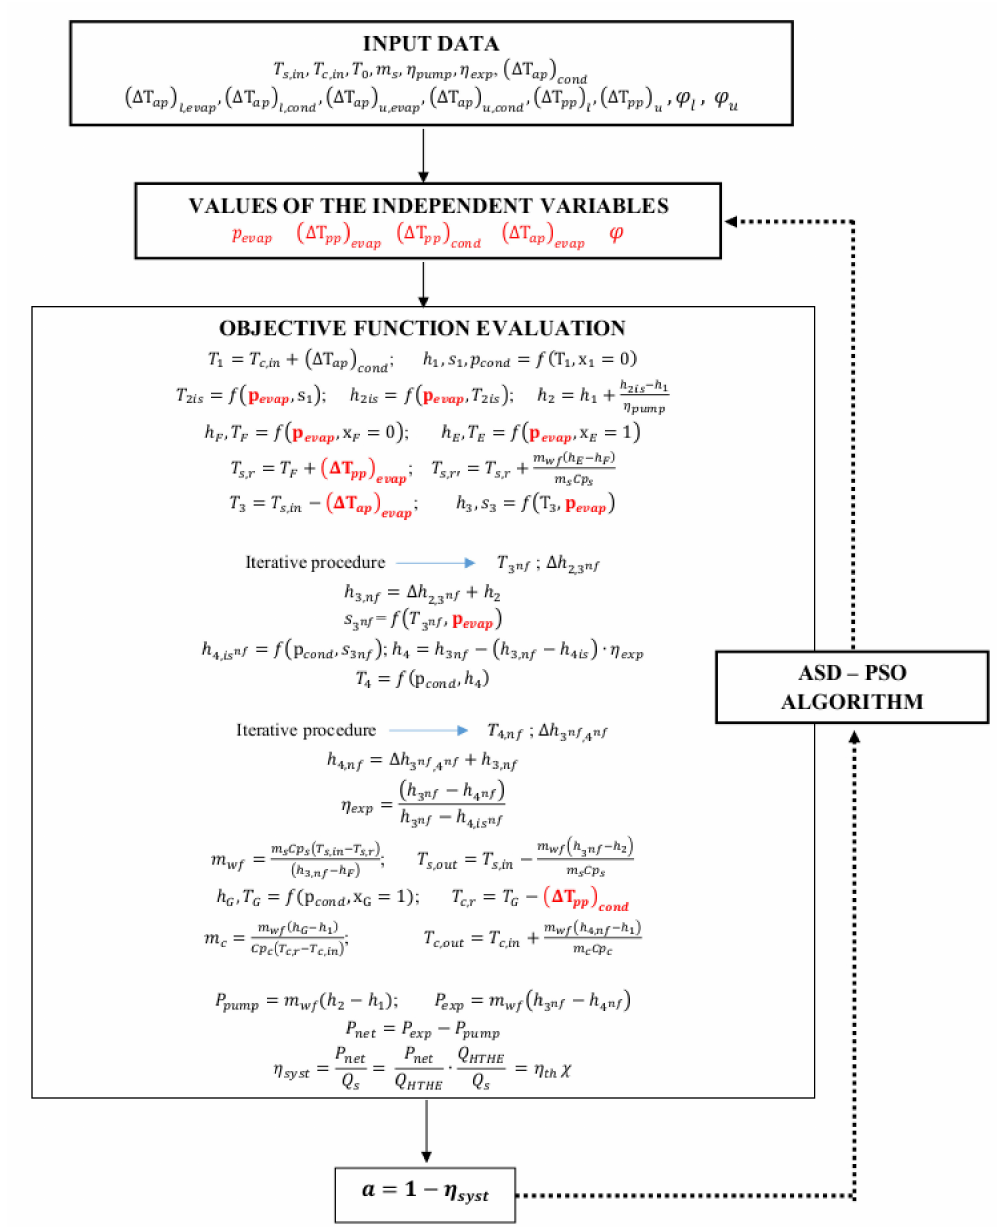
Figure 5. Flow chart of the optimization